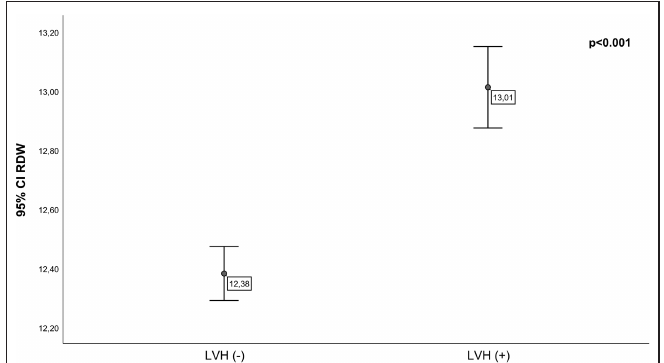
Figure 2. Comparison of red cell distribution width between left ventricular hypertrophy